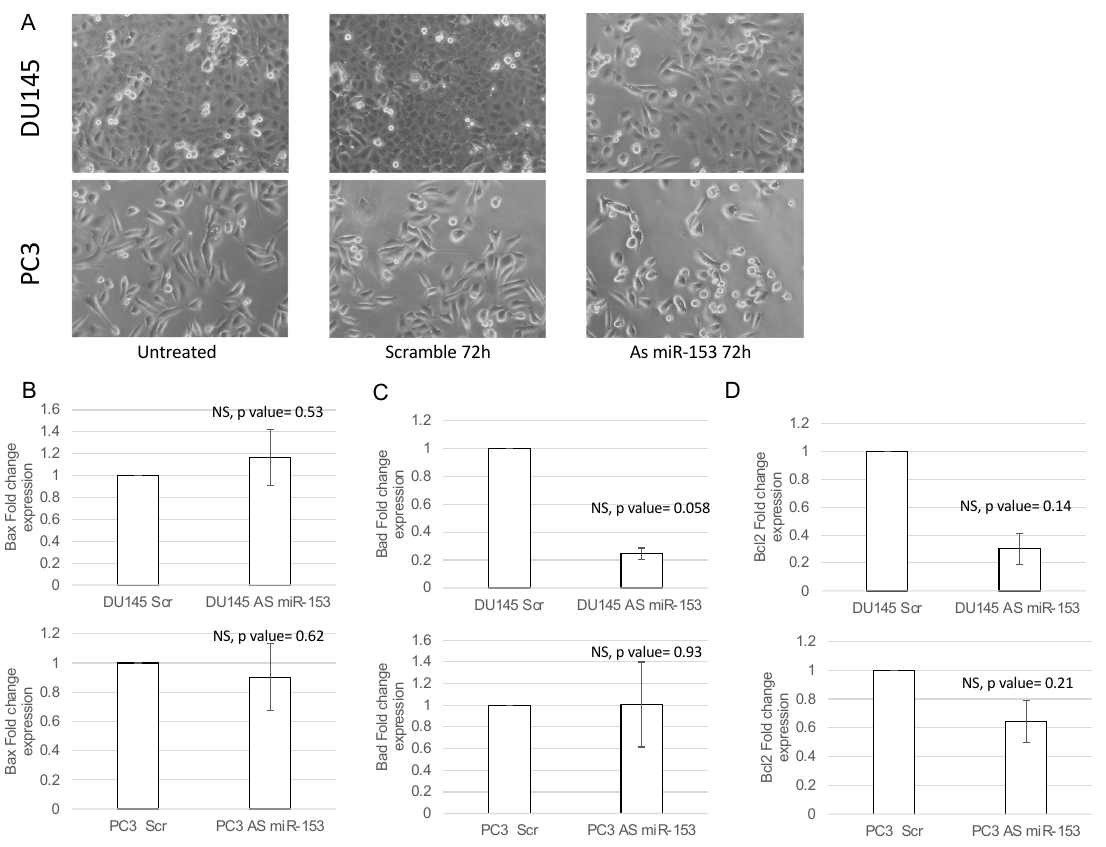
Figure 5. miR-153 silencing caused decreased confluency in both cell lines. ( A ) Phase contrast 20 × images of DU145 and PC3 untreated (on the left), 200 nM Scr-treated (on the center), or As miR-153-treated cells (on the right). Fold change expression (2 − ∆∆ CT ± sd) of Bax ( B ), Bad ( C ) and Bcl2 ( D ) apoptotic genes in DU145 (upper panels) or PC3 (lower panels) treated with 200 nM 72 h scramble (Scr) or Antisense miR-153 (As) oligonucleotides. Summary of two experiments in triplicate ( t test compared to scramble treated cells, NS, not